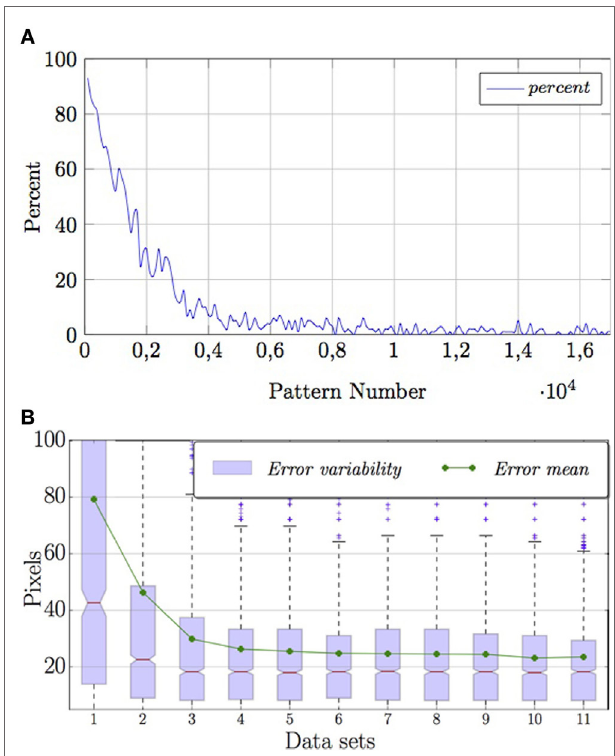
FigUre 7 | Performance of the system during training . (a) Average percentage of random motor commands used as learning occurs. (B) Error in pixels between final position and center of image.